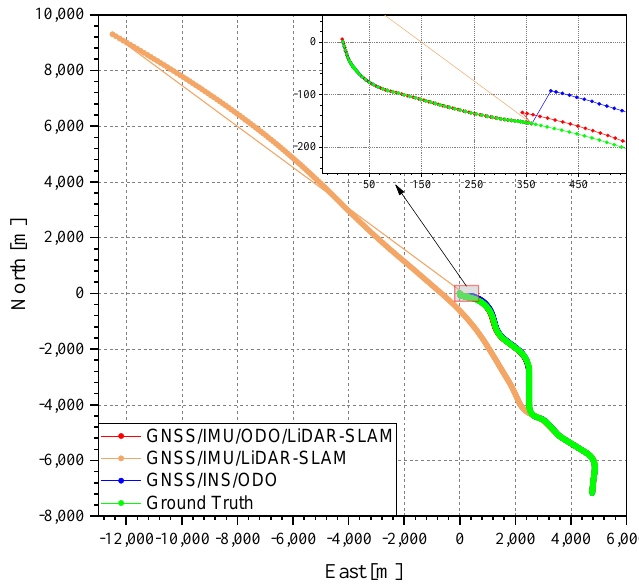
Figure 11. Trajectories in the East Lake Tunnel test. Sensors 2020 , 20 , x FOR PEER REVIEW 15 of 18